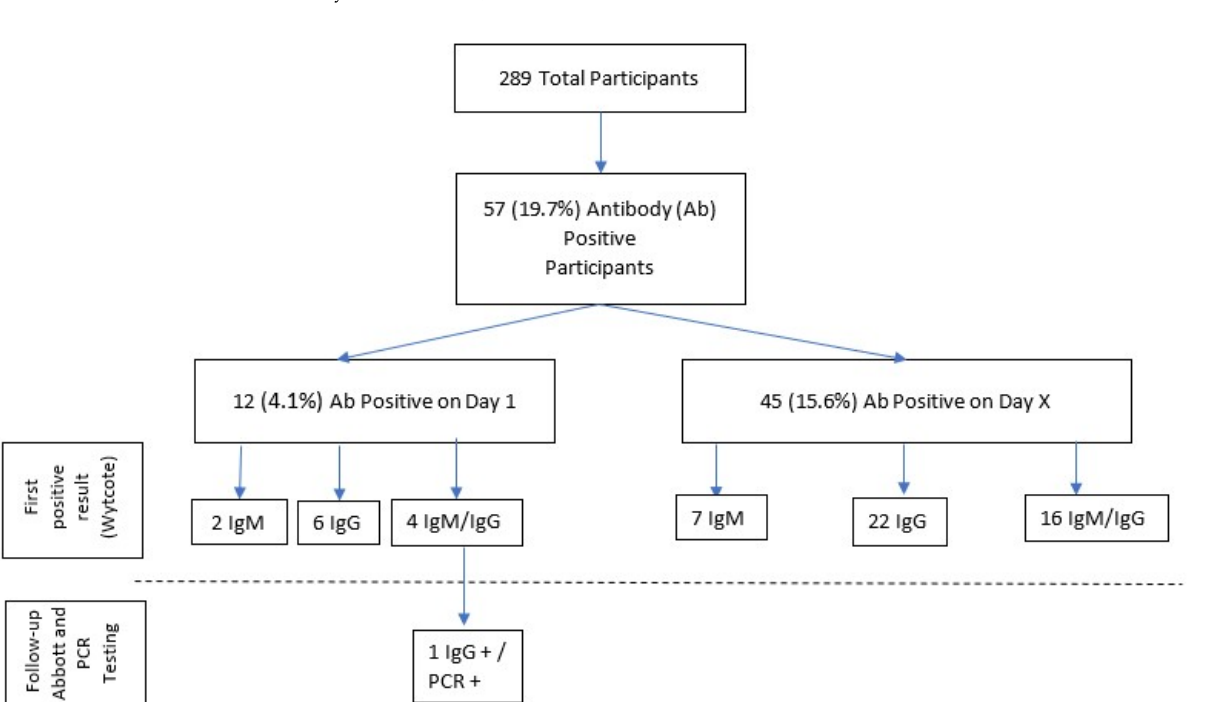
Figure 1. Flow Diagram of Results for Antibody Positive Participants. Positive antibody results from participants over time, broken into first positive Wytcote result, IgG follow-up testing via the Abbott assay and PCR follow-up testing. IgM—Immunoglobulin M, IgG—Immunoglobulin G, Ab-Antibody